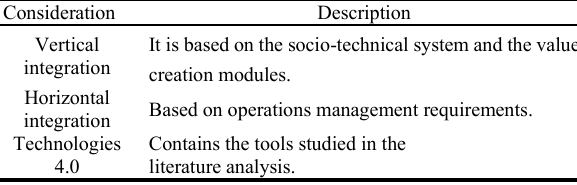
Table 2. Organizational Structure